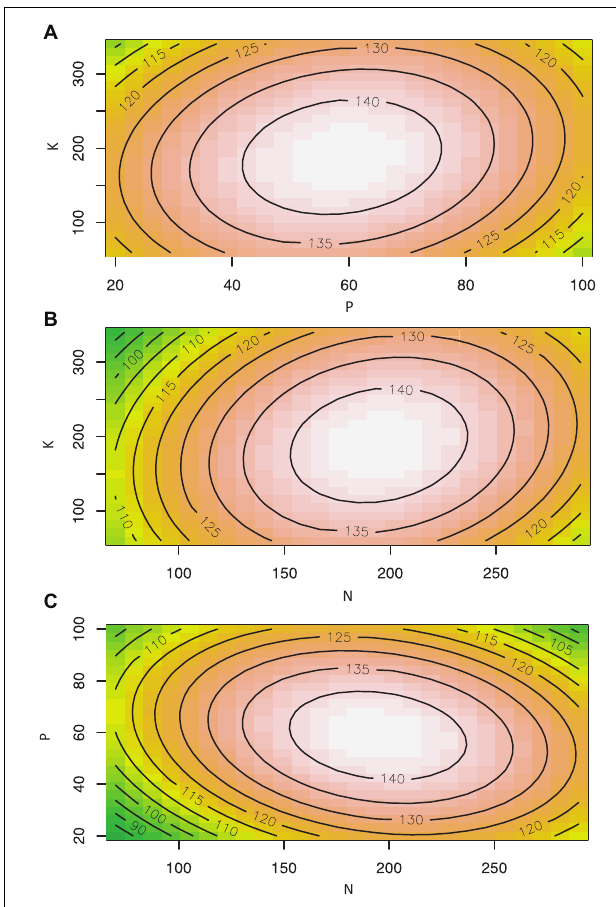
FIGURE 3 | Contour plots showing the effect of nutrient solution N, P, and K concentrations (mg L − 1 ) on inflorescence yield (g/plant) of Cannabis sativa grown in deep water culture ( P ≤ 0.05, R 2 = 0.57). (A) Contour plot of P vs. K at N = 180 mg L − 1 . (B) Contour plot of N vs. K at P = 60 mg L − 1 . (C) Contour plot of N vs. P at K = 200 mg L − 1 .